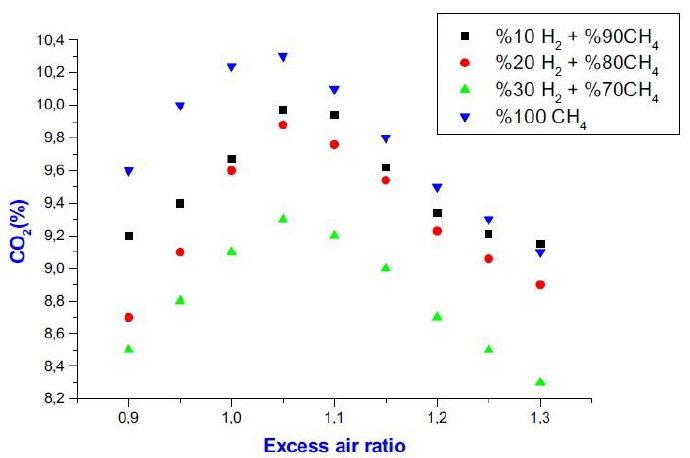
Figure 15. Reducing CO 2 emission using hydrogen fuel in gasoline engines [75].